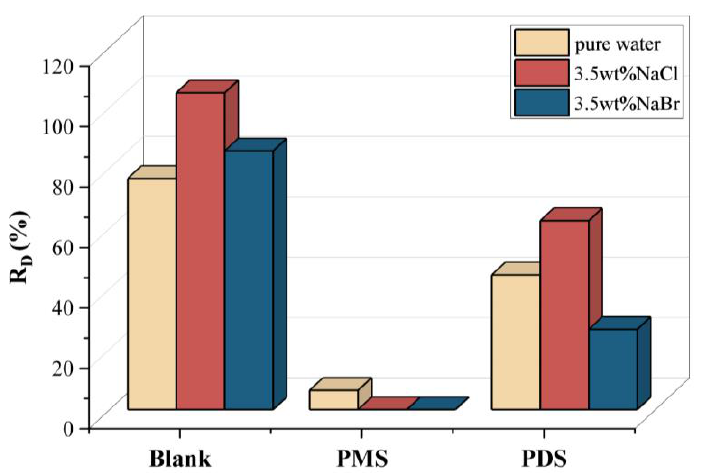
Figure 3. The R D values of phenol with and without the addition of PMS and PMS in pure water, 3.5 wt% NaCl solution, and 3.5 wt% NaBr solution. Experimental conditions: [Phenol] 0 = 1 mg/L, solar intensity = 1 kW/m 2 , [PMS] = 2 mmol/L, [PDS] = 2 mmol/L.